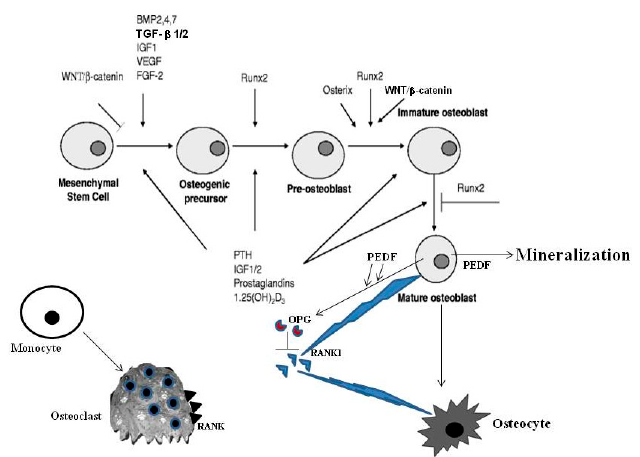
Figure 1. Schematic representation of cell types and major regulators of the molecular pathways involved in osteoblastogenesis and bone formation.